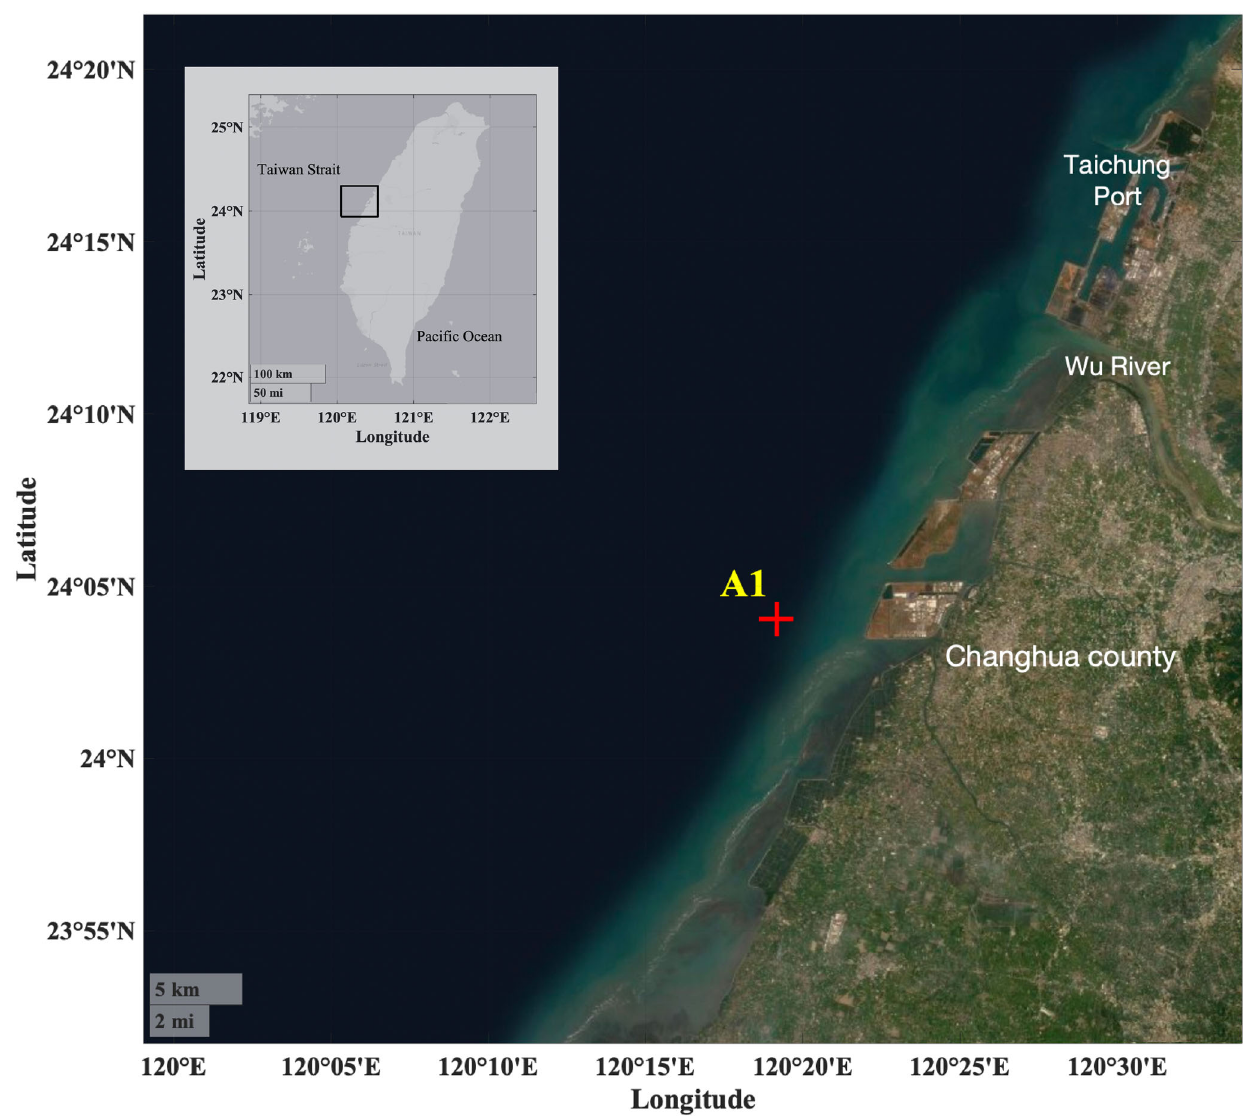
Fig. 5 Study area located off the Taiwan Strait. Map of the Changhua coast located in Taiwan Strait, Taiwan depicting the deployed passive acoustic monitoring recorder at site A1. The map was produced in Matlab 9.11 (The Mathworks, Natick, MA; http://www.mathworks.com/) using mapping toolbox function geobasemap() . Full global basemap composed of high-resolution satellite imagery hosted by